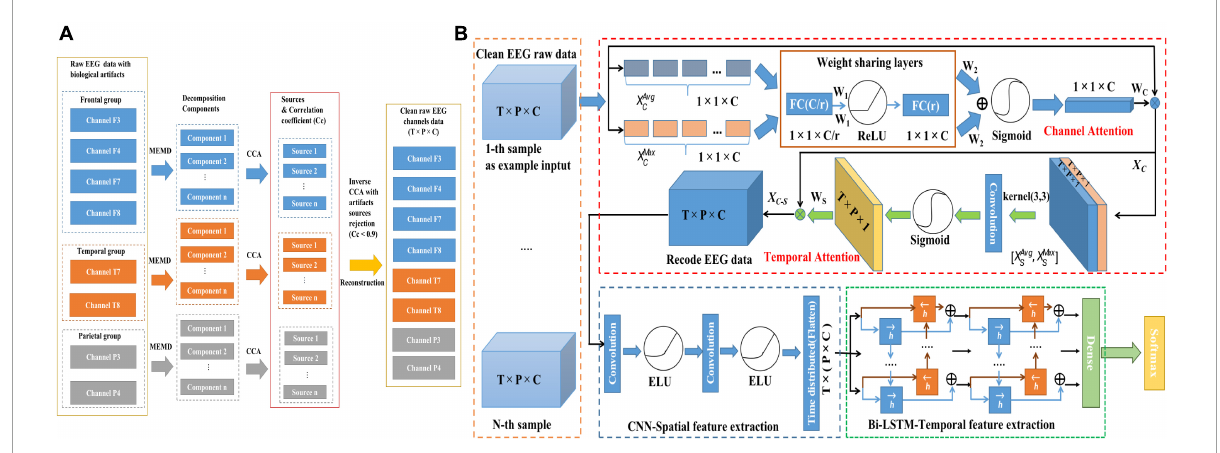
FIGURE3 Illustration of the proposed framework based on raw EEG data for emotion recognition. (A) Removal of biological artifacts by MEMD-CCA. (B) CTA-CNN-Bi-LSTM